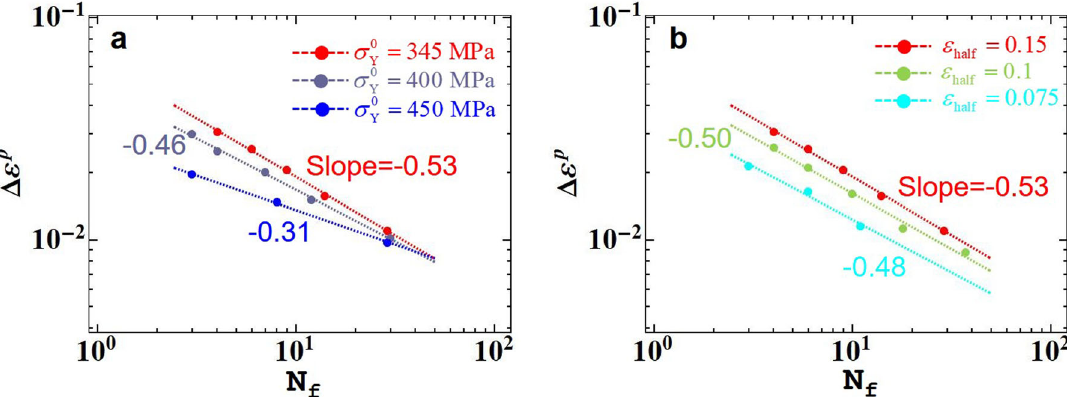
. b Results with Y